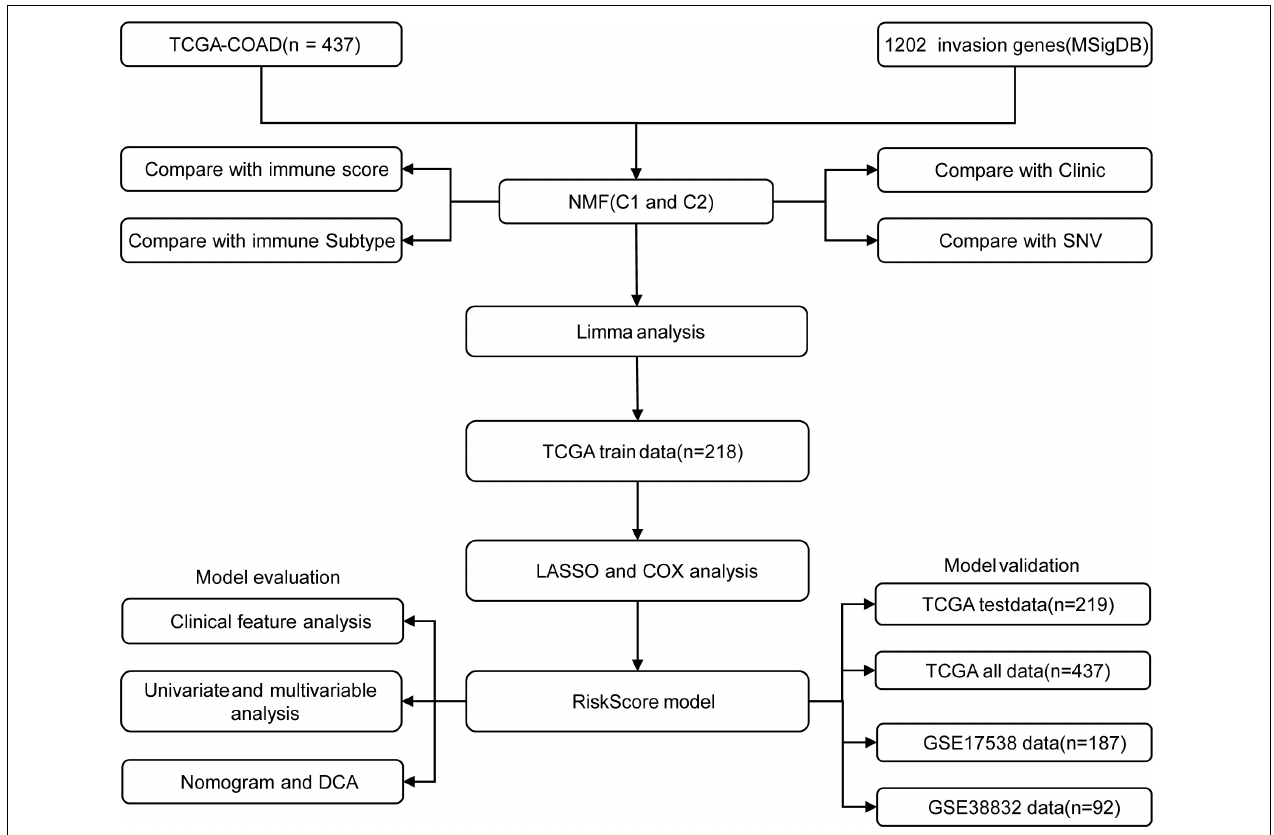
FIGURE 1 | The study flow